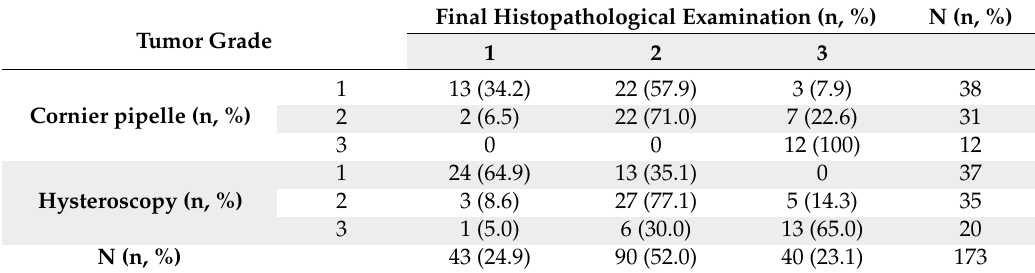
Table 5. Concordance on tumor grade MRI and final histopathological examination on endometrial biopsy by Cornier pipelle and